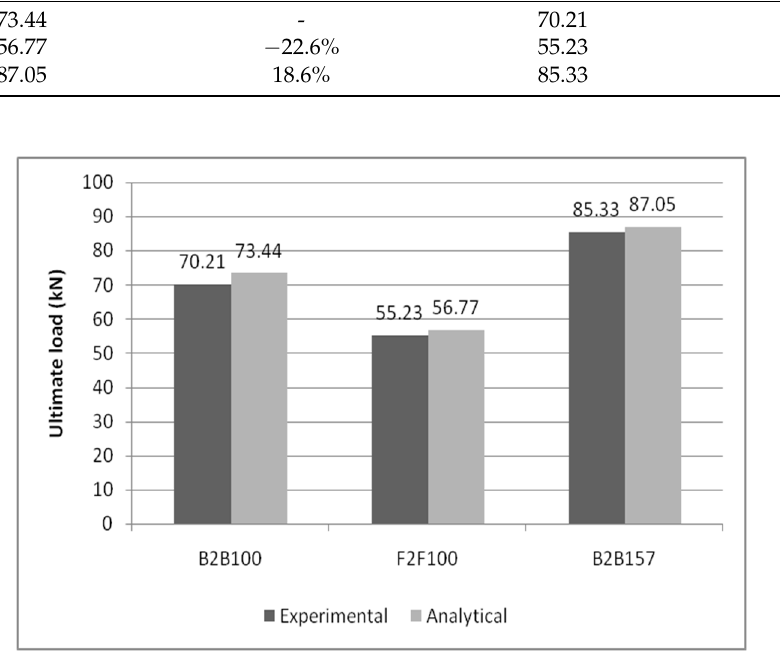
Figure 16. Load vs. deflection for B2B100.